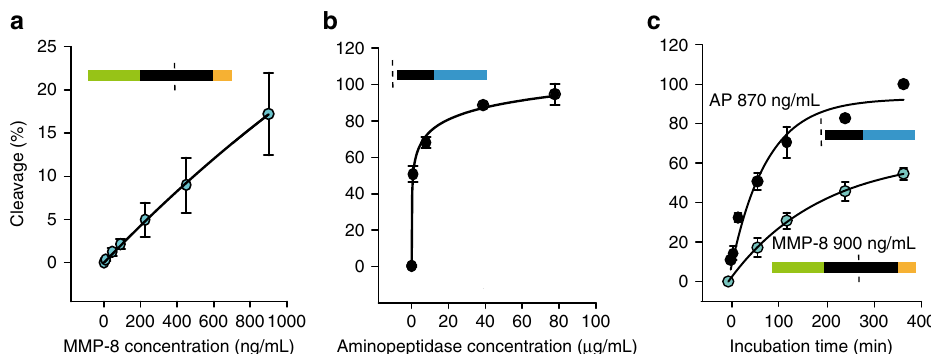
Fig. 2 Concentration and incubation time-dependent cleavage of the PCL denatonium or PCL carboxy fl uorescein conjugates. a Cleavage (%) of the PCL (Cf-CLAN 3 Q in Supplementary Table 1; Fig. 1a) as a function of MMP-8 concentration within 60 min. n = 10. b cleavage (%) of the peptide denatonium fragment (i.e., IAGQK-De in Supplementary Table 1; Fig. 1b) as a function of aminopeptidase concentration within 60 min. n = 5. c Impact of incubation time on cleavage (%) of the PCL using 900 ng/mL MMP-8 n = 8, and on the peptide denatonium fragment using 870 ng/mL aminopeptidase n = 5. All data are presented as mean ± s.d. and each experiment was repeated at least once